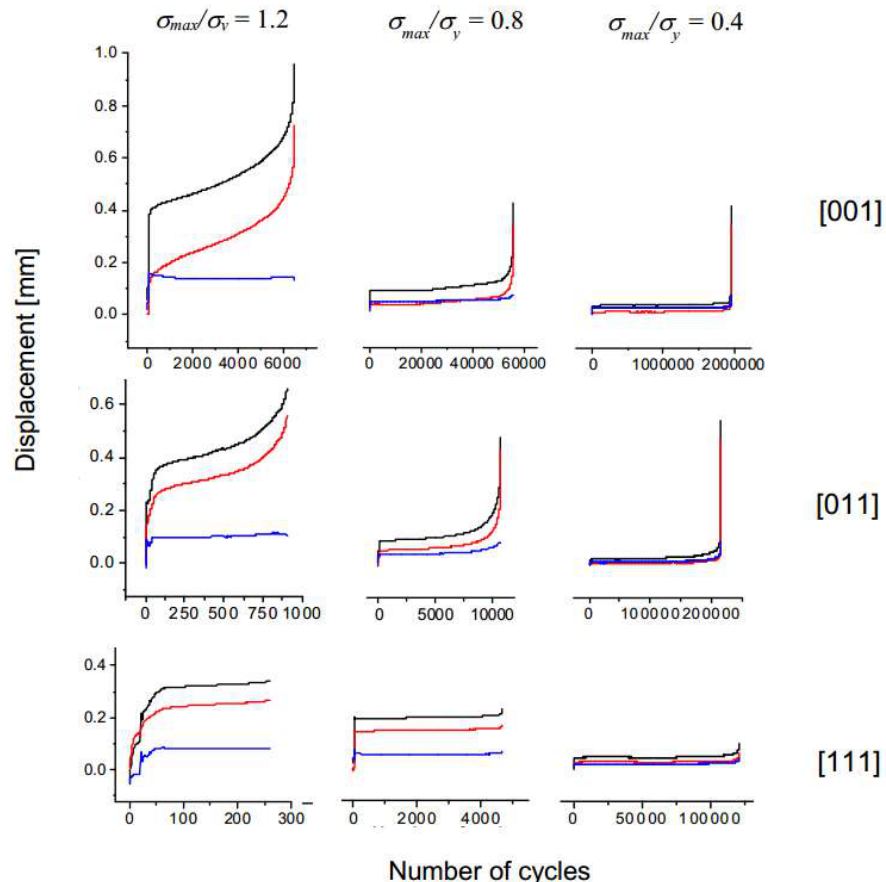
Figure 15. Plots of the peak (black) and valley (red) displacements, and their difference (blue) for analysis of the damage evolution for three orientations.